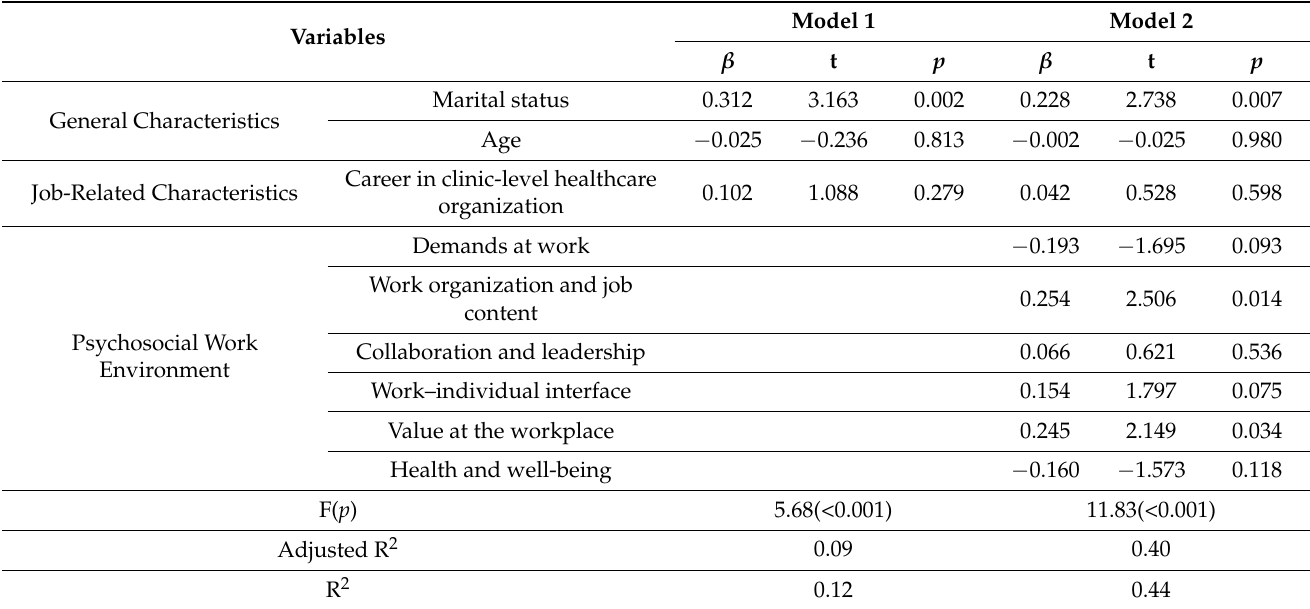
Table 2. Factors Influencing Intention to Stay ( N =